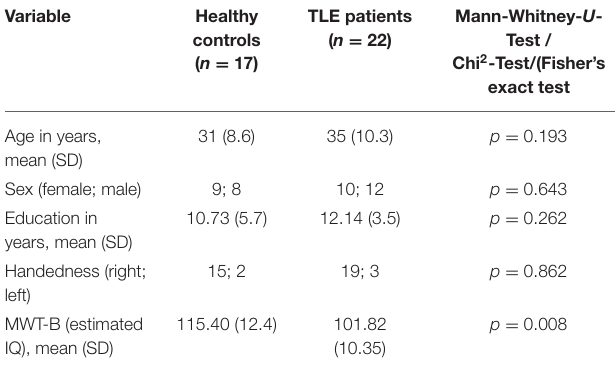
TABLE 1 | Characteristics of patients and healthy